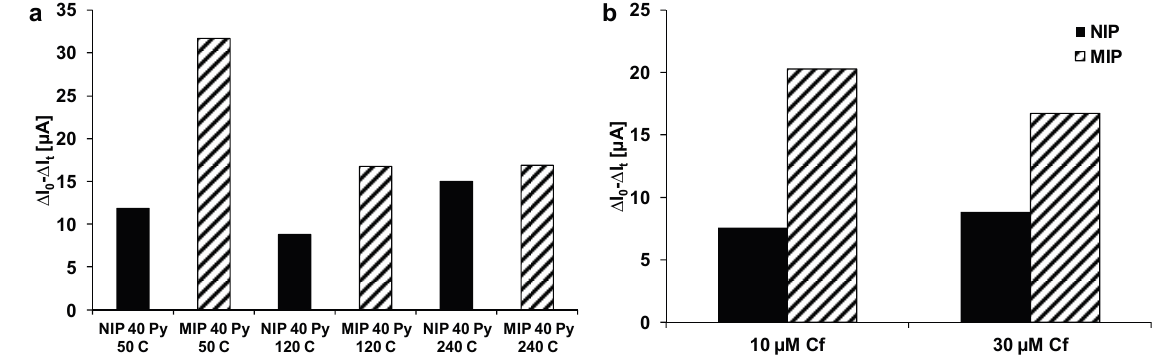
Figure 4. PAD sensor response of MIP and NIP to clofibric acid solutions. ( a ) PAD response to 30 µM clofibric acid solution of NIP and MIP prepared with 50, 120, and 240 cycles (40 mM pyrrole); ( b ) PAD response to 10 and 30 µM clofibric acid solution of NIP and MIP prepared with 120 cycles (40 mM